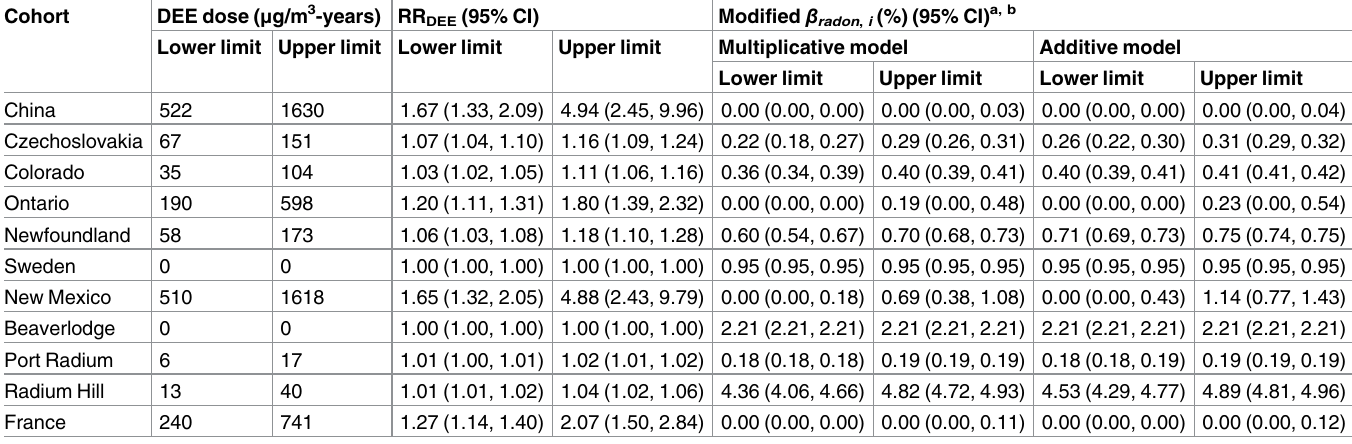
Table 2. Modified β radon , i in the 11 miner